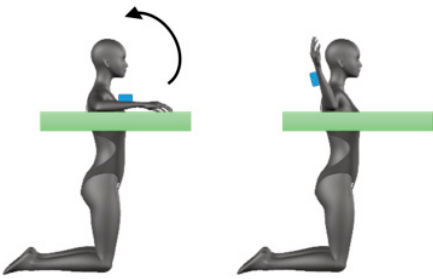
Figure 2. Mobility of shoulder: sensor positioning and movement direction for the extra-rotation task. Hip